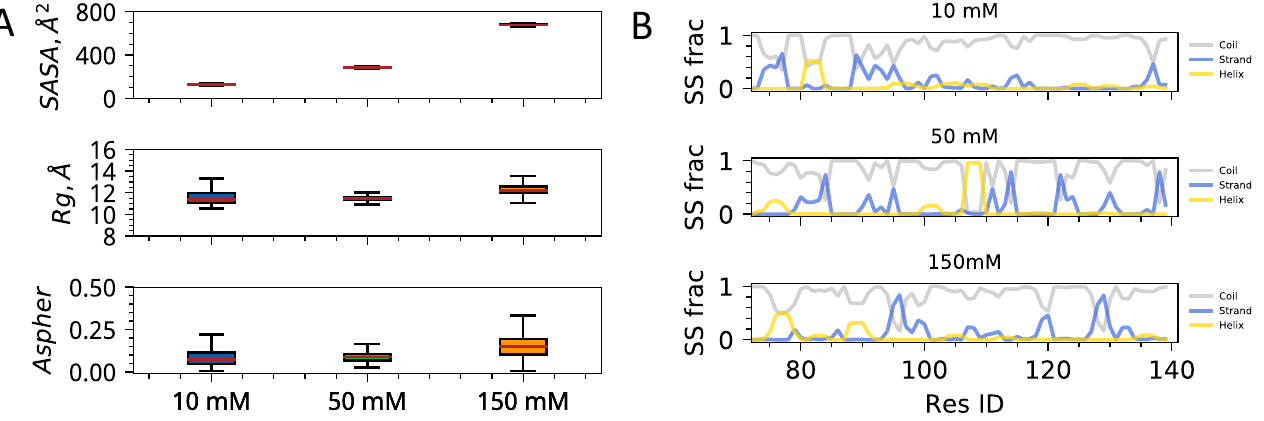
Figure 2. Polymeric properties of hinge region as a function of ionic strength. ( A ) Solvent-accessible surface area (SASA), Radius of gyration (Rg), and Asphericity (Aspher) as a function of ionic strength. Error bars show standard deviations from the sampled mean. ( B ) Secondary structure content computed as a function of sequence position. Panels from top to down show results from simulations of single chains under distinct ionic conditions. Different colors in each panel correspond to coil, strand, and helical